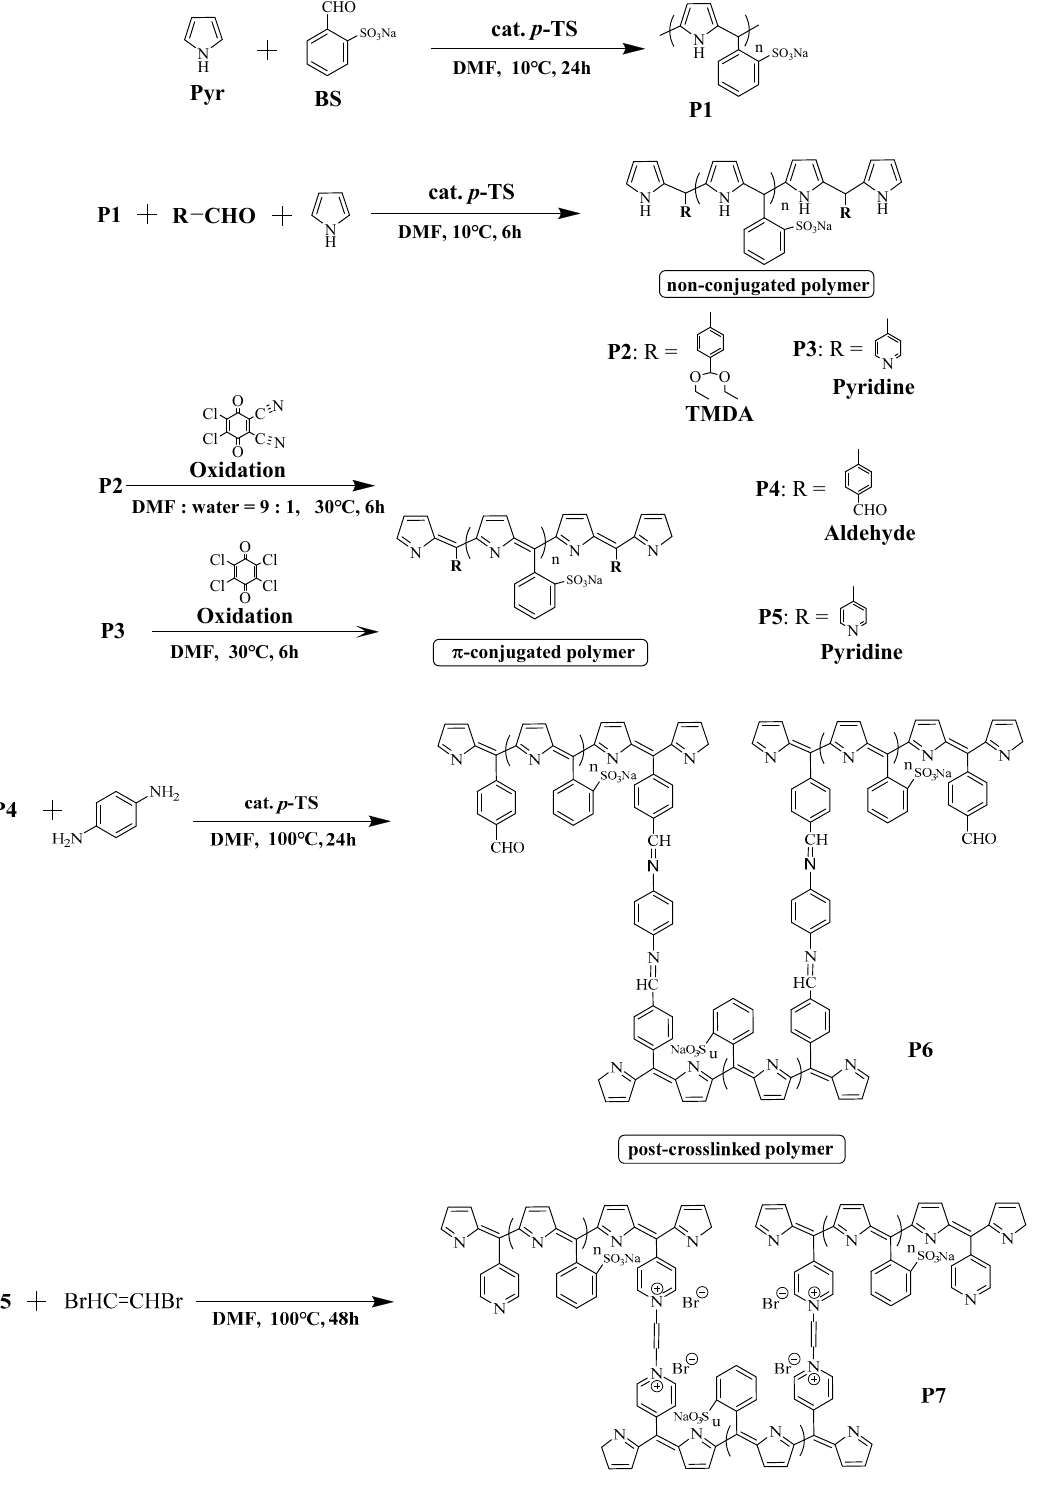
Scheme 1. Synthesis of polymers.